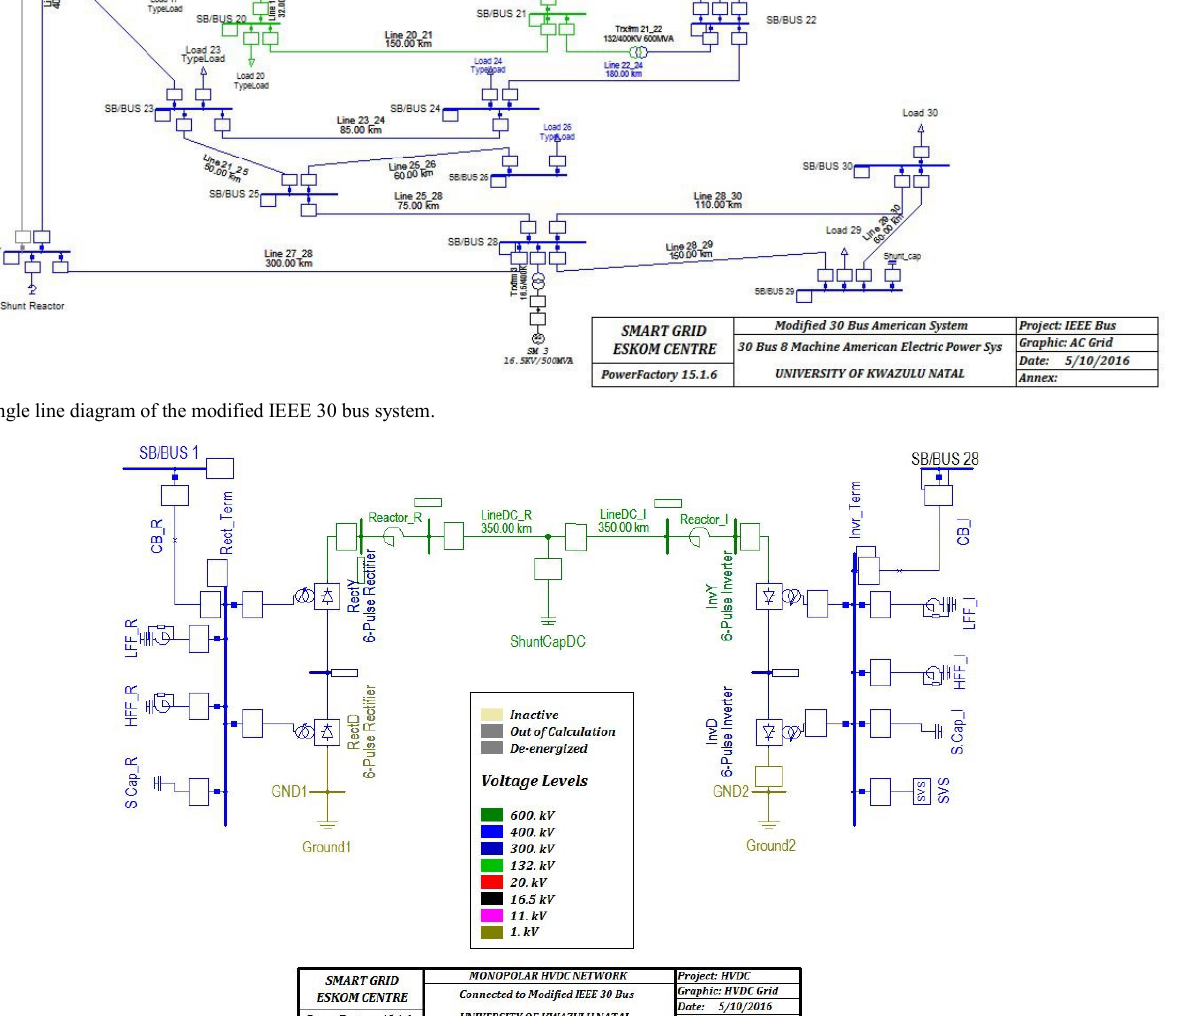
Fig. 3. Monopolar HVDC